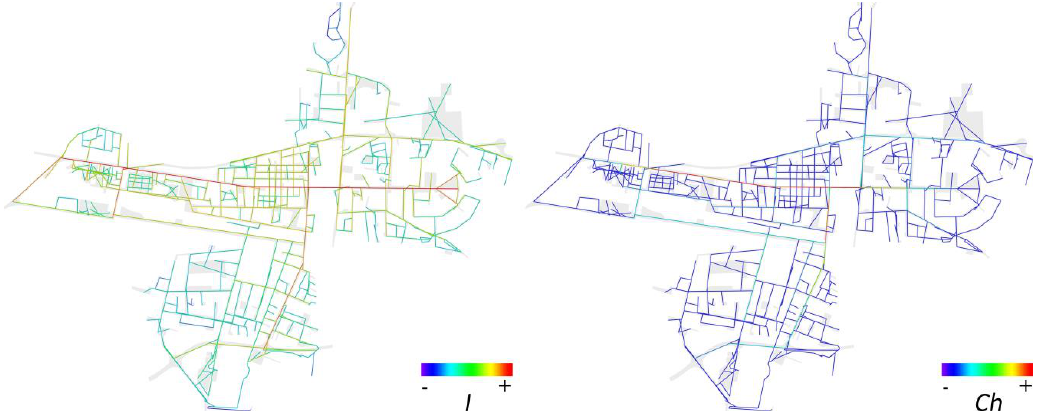
Figure 5. Results of the angular segment analysis of Pontedera, colour maps of: integration index, I ( left ), and choice index, Ch ( right ).